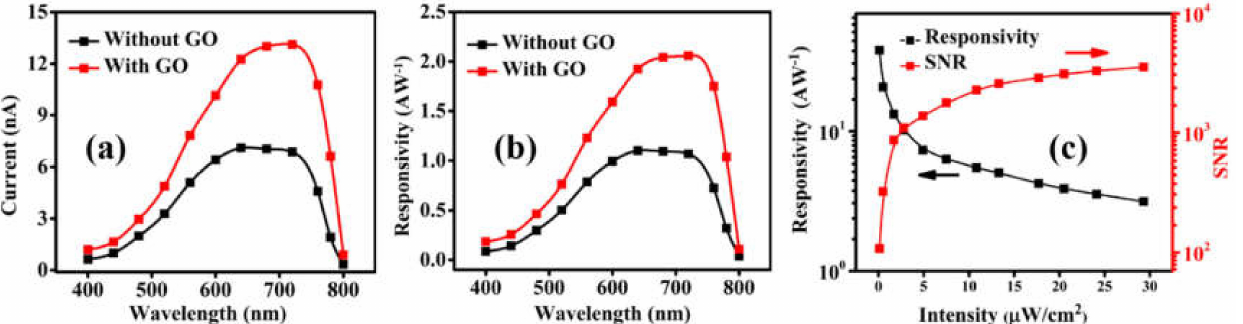
Figure 5. ( a ) Photo current spectra, ( b ) responsivity spectra of the single layer and the trilayer photodetector measured with a light illumination of 10.6 µ W/cm 2 and a bias voltage of 5 V. ( c ) The signal to noise ratio and responsivity of the trilayer photodetector as functions of illumination power of incident white